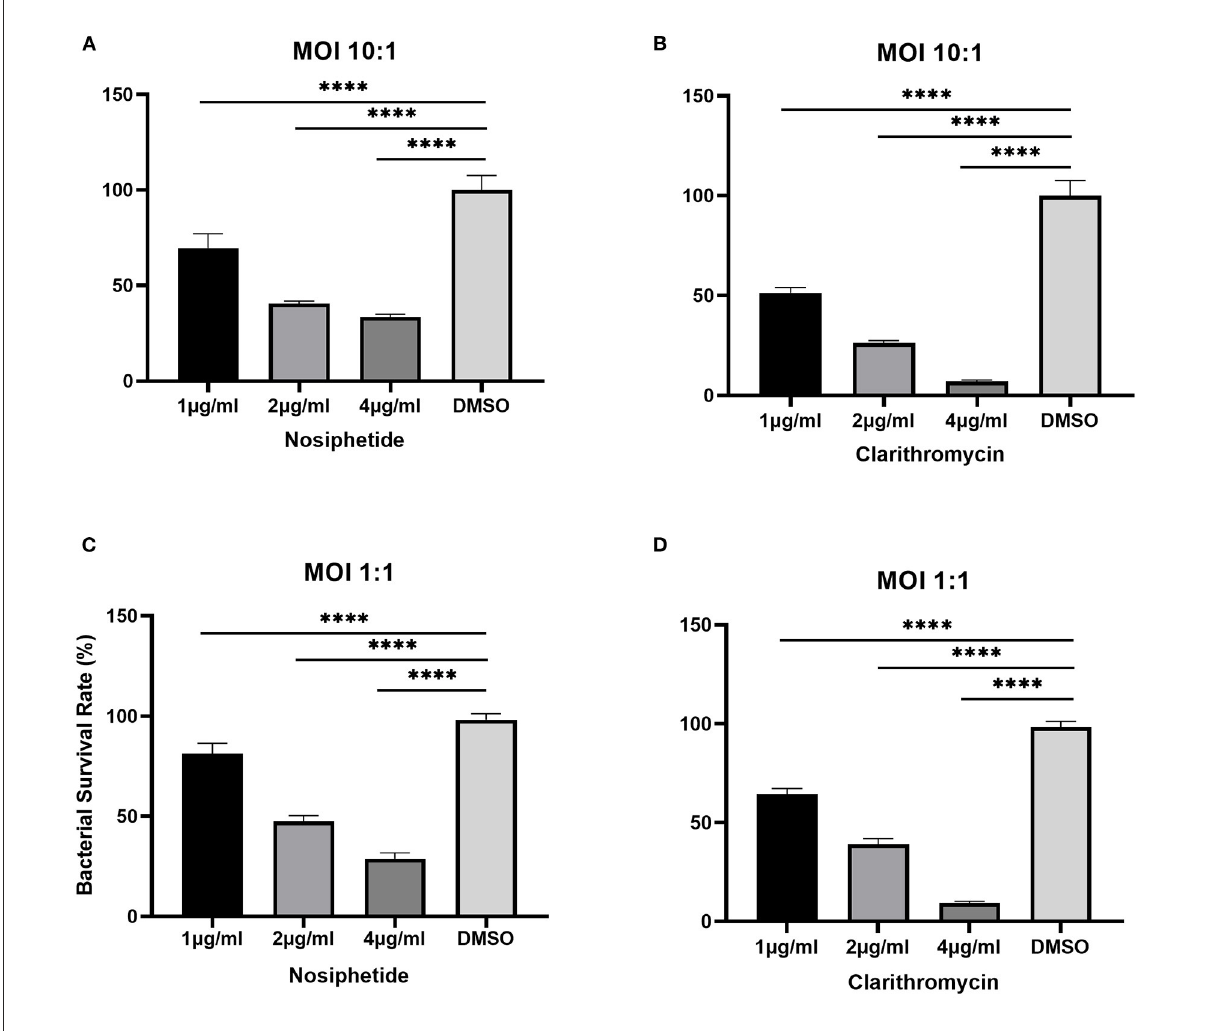
FIGURE6 Intracellular bactericidal activities of different concentrations of nosiheptide (NOS) and CLA (the positive control) against M. abscessus ATCC 19977 in macrophages. (A) NOS at an MOI of 10:1. (B) clarithromycin at an MOI of 10:1. (C) NOS at an MOI of 1:1. (D) clarithromycin at an MOI of 1:1. DMSO group: the negative control. All data are shown as the means ± SD ( n = 3). **** P <